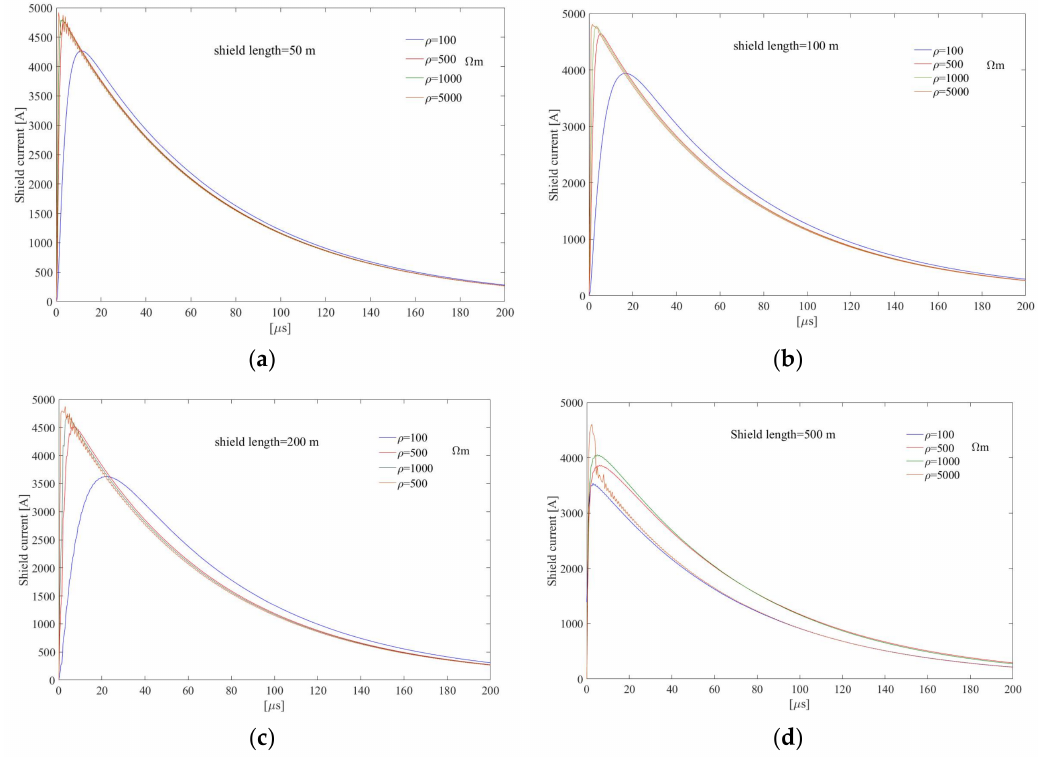
Figure 4. Current time profiles in the equivalent 3 × 6 mm 2 metal shields. The distance between the substations is set equal to: ( a ) 50 m; ( b ) 100 m; ( c ) 200 m; ( d ) 500